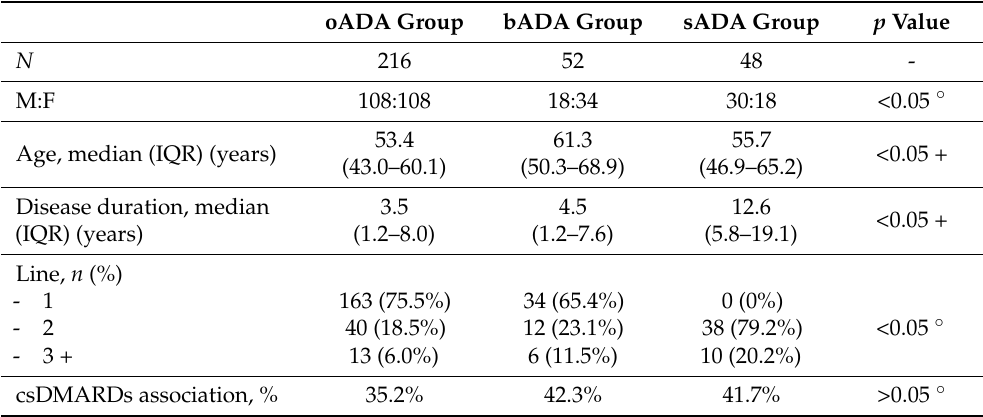
Table 3. PsA cohort